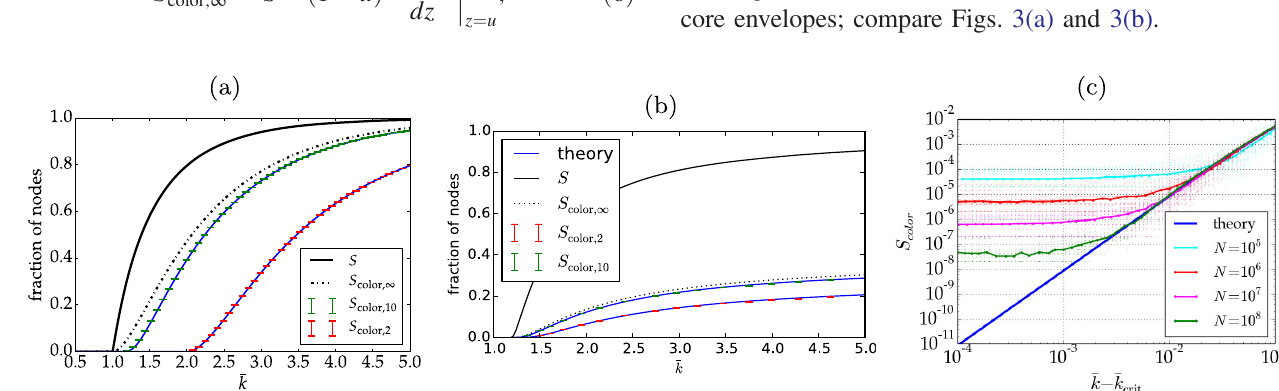
FIG. 3. Size of the giant color-avoiding component S in random networks with uniformly distributed colors. We show the color ¯ k (a) for Erd ő s-Rényi networks and (b) scale-free networks with different numbers of colors. dependence of S on average degree color Standard-deviation error bars are shown but barely visible for networks of size N ¼ 10 6 . The blue lines show the corresponding analytical results. For comparison, we include the giant component size of standard percolation S (black solid line) and the limiting case of a system with an infinite number of colors, S (black dashed line). As mentioned in the text, S is the same as the giant color ; ∞ color ; ∞ component in two-core percolation. (c) Critical exponent and finite-size scaling for Erd ő s-Rényi networks with C ¼ 3 . Note that in the critical region, the theory and simulations show a slope of almost exactly 3 as predicted by Eq. (8). Finite-size scaling is shown, with results of > 150 realizations per size plotted individually and